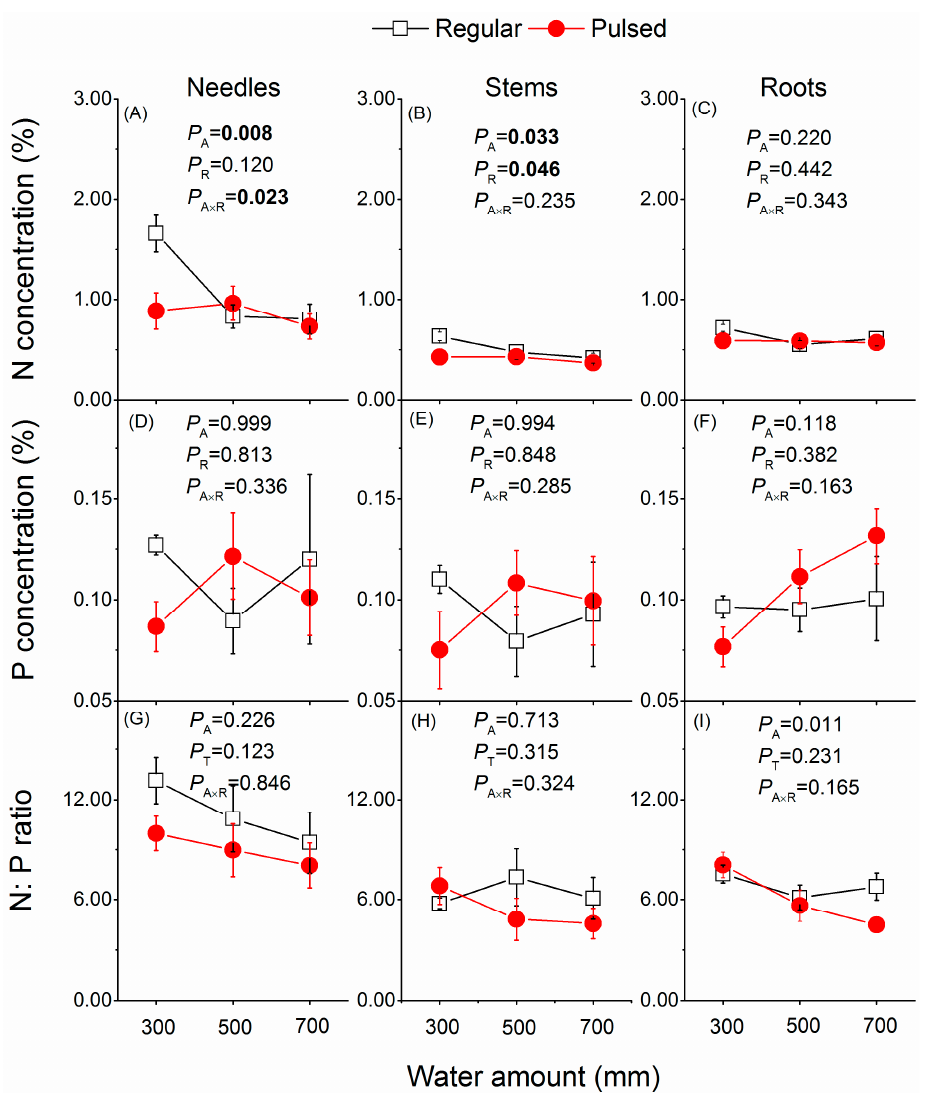
Figure 6. Effects of the watering regime (regular vs. pulsed) and water amount (300, 500, and 700 mm) on concentrations of N ( A – C ), P ( D – F ), and N to P ratio ( G – I ) in different tissues of P. massoniana saplings. p values of two-way ANOVAS are given. A and R represent water amount and watering regime, respectively. Plotted are means ± SE.